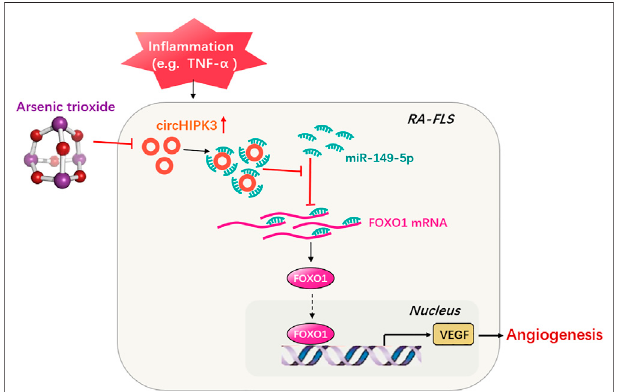
FIGURE 7 | Schematic illustration underlying the mechanism of ATO ’ s effect on the circHIPK3/miR-149-5p/FOXO1/VEGF functional module. CircHIPK3 might act as a sponge for the FOXO1-targeting miR-149-5p, leading to the downregulation of downstream VEGF. These networked factors mainly form a functional module regulating angiogenesis in RA-FLS, and the expression of this functional module could be signi fi cantly downregulated by ATO, ultimately inhibiting